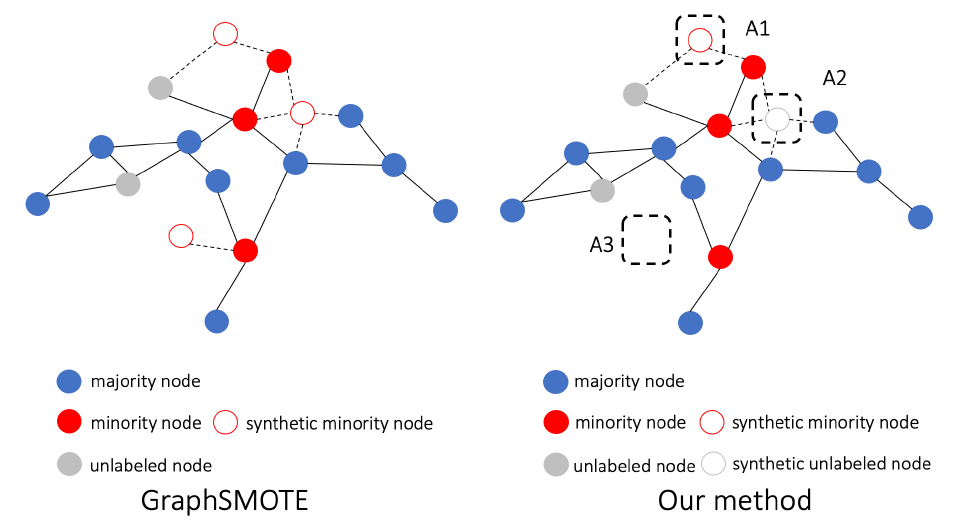
Figure 2. A comparison between our method and the current state-of-the-art graph over-sampling method GraphSMOTE [17]. In the current method, the idea is to generate new minority instances near randomly selected minority nodes and create virtual edges (dotted lines in the figure) between those synthetic nodes and real nodes. Instead, we synthesize minority instances in safe areas (i.e., A1), generate unlabeled instances in locally balanced areas (i.e., A2), and do not conduct data over- sampling near minority nodes that are outliers (i.e., A3). For the simplicity of illustration, only a single-label scenario is